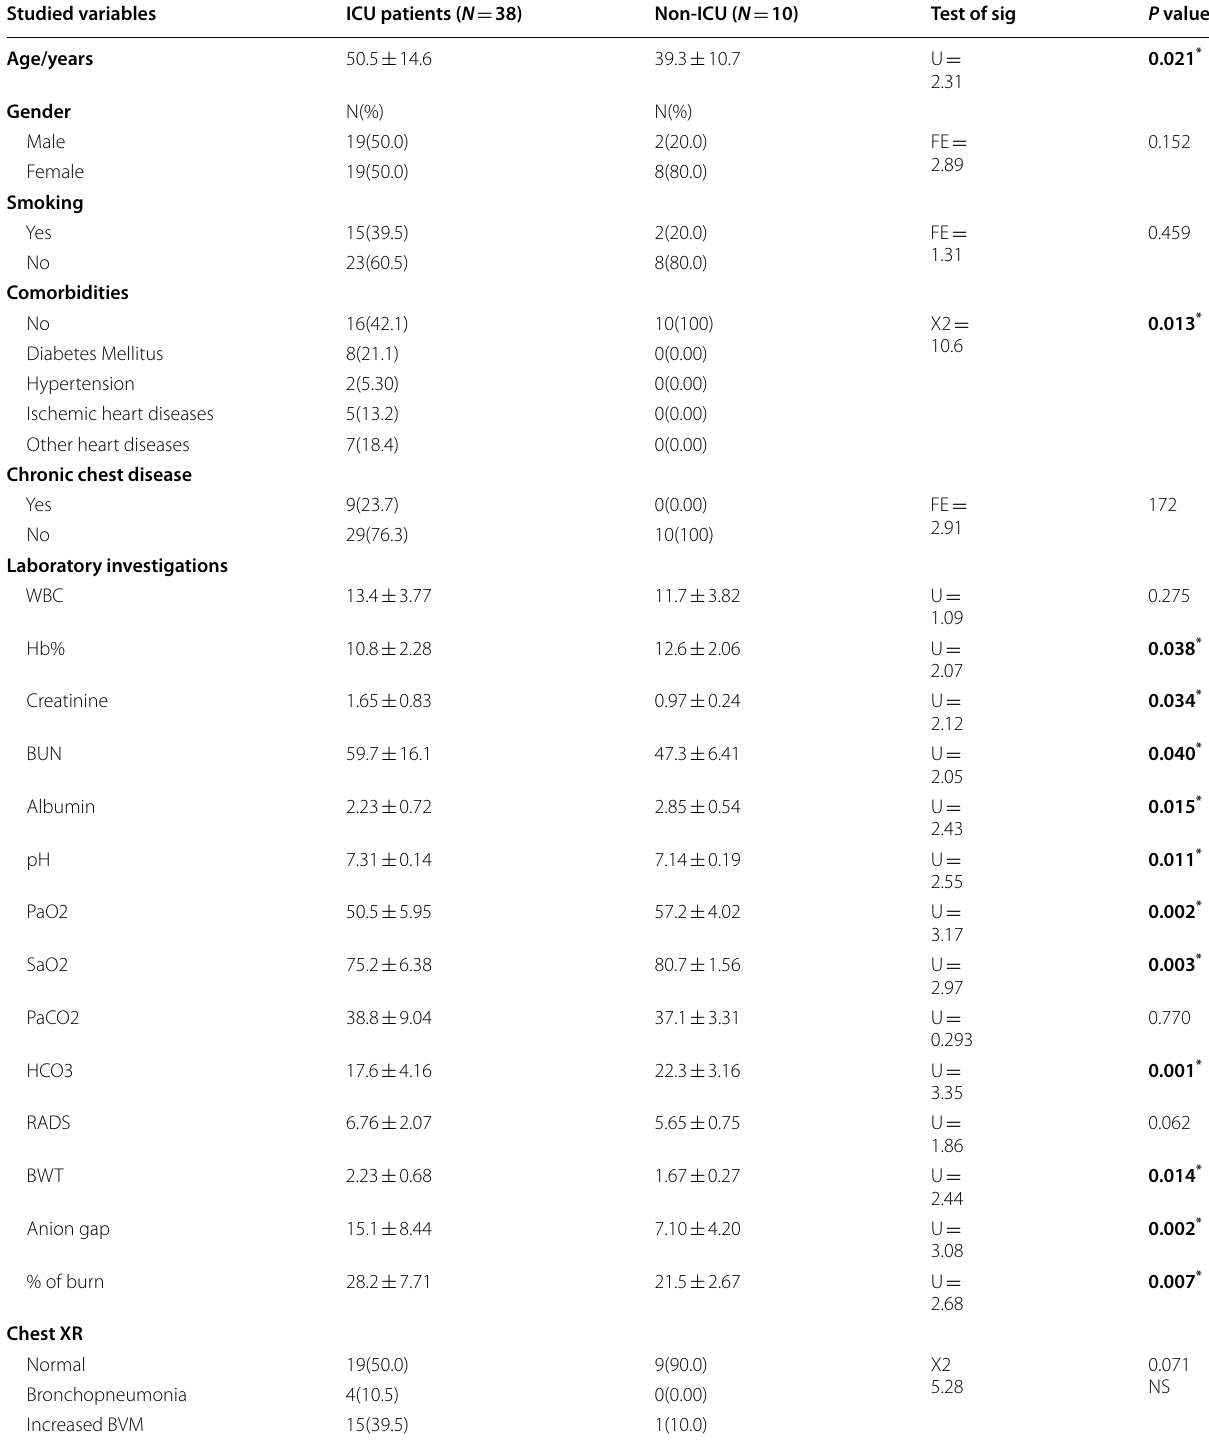
Table 4 Comparison between ICU admission and non‑ICU admission among patients with